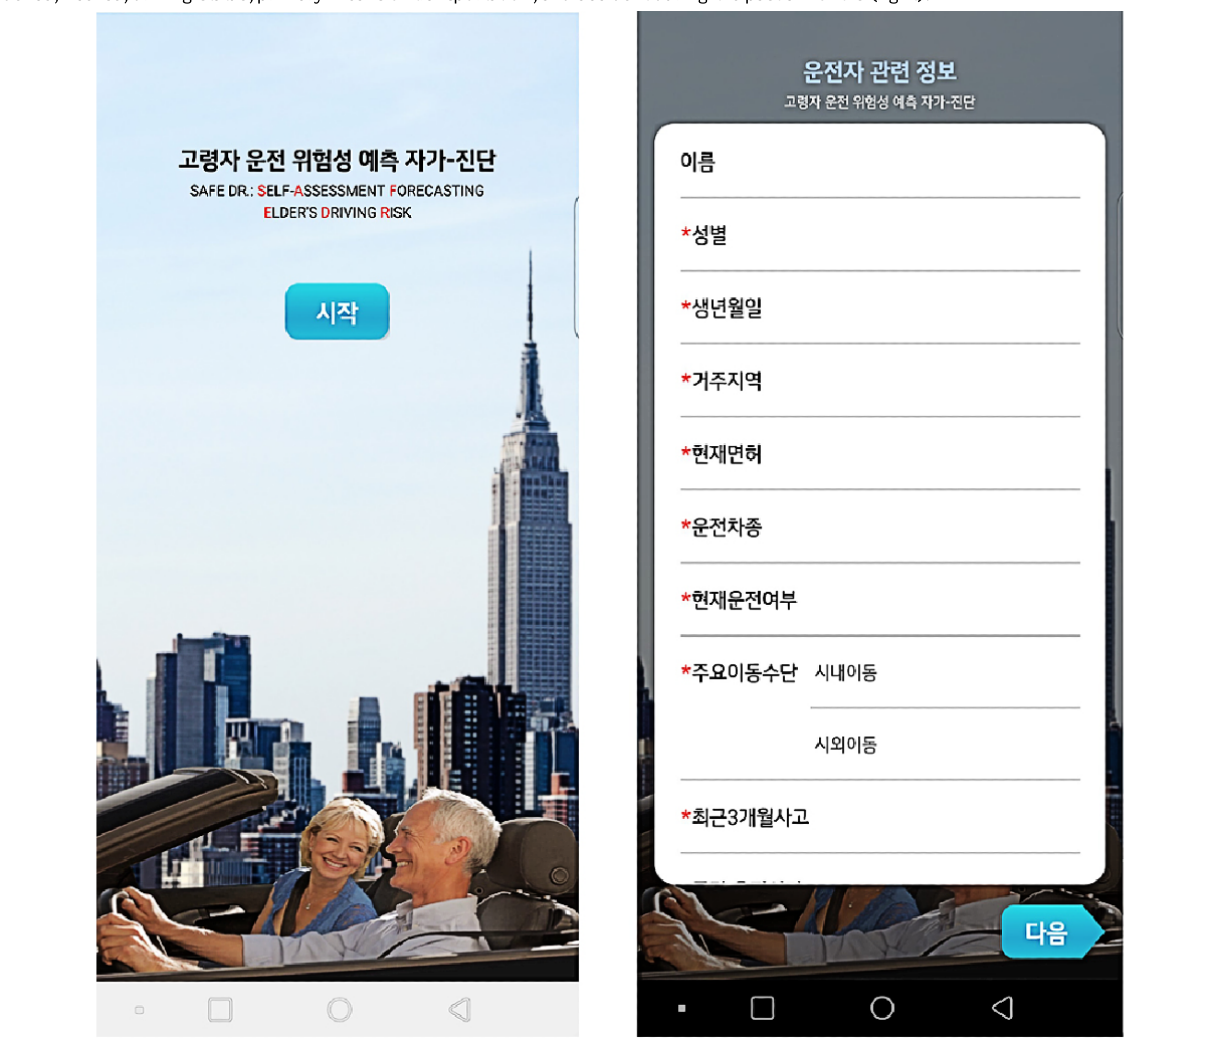
Figure 1. Title and information collection screenshot of the Android app: title page (left) and driver-related information such as gender, date of birth, residence, license, driving status, primary means of transportation, and accident during the past 3 months (right).